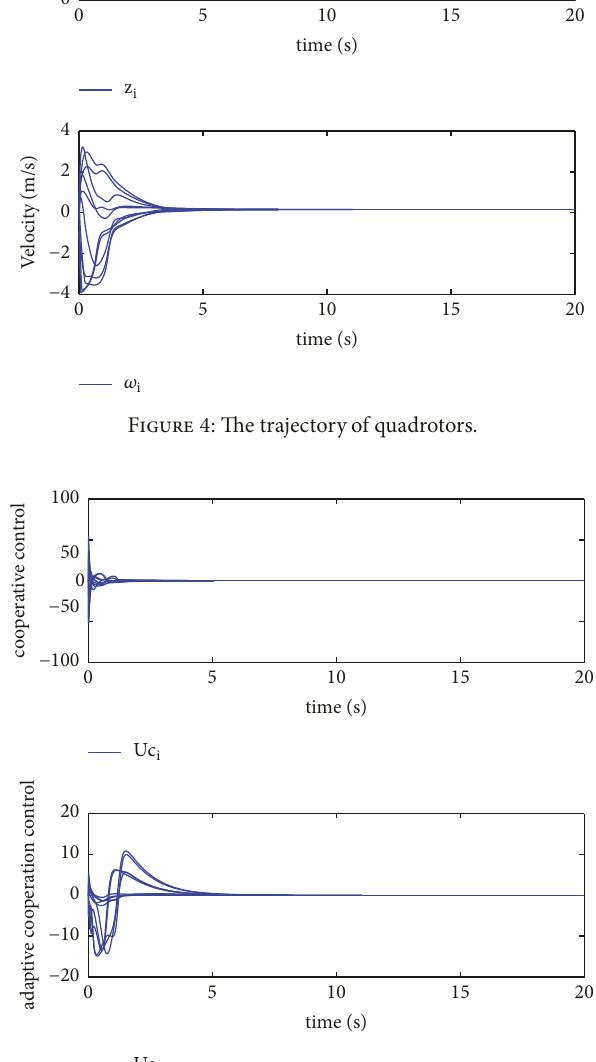
Figure 5: Adaptive cooperation control